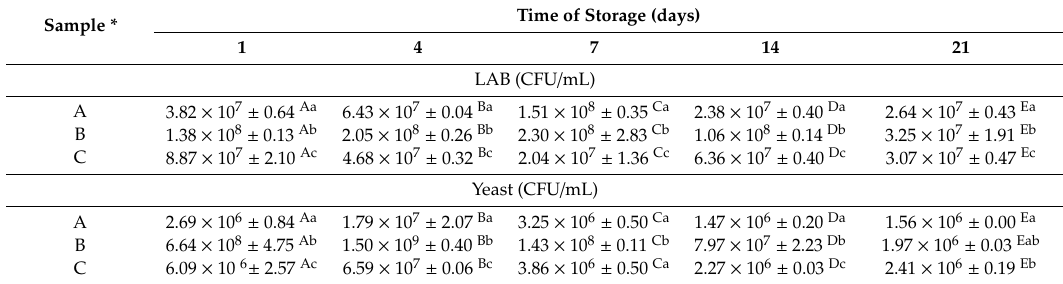
Table 2. Lactic acid bacteria (LAB) and yeast counts during storage time.